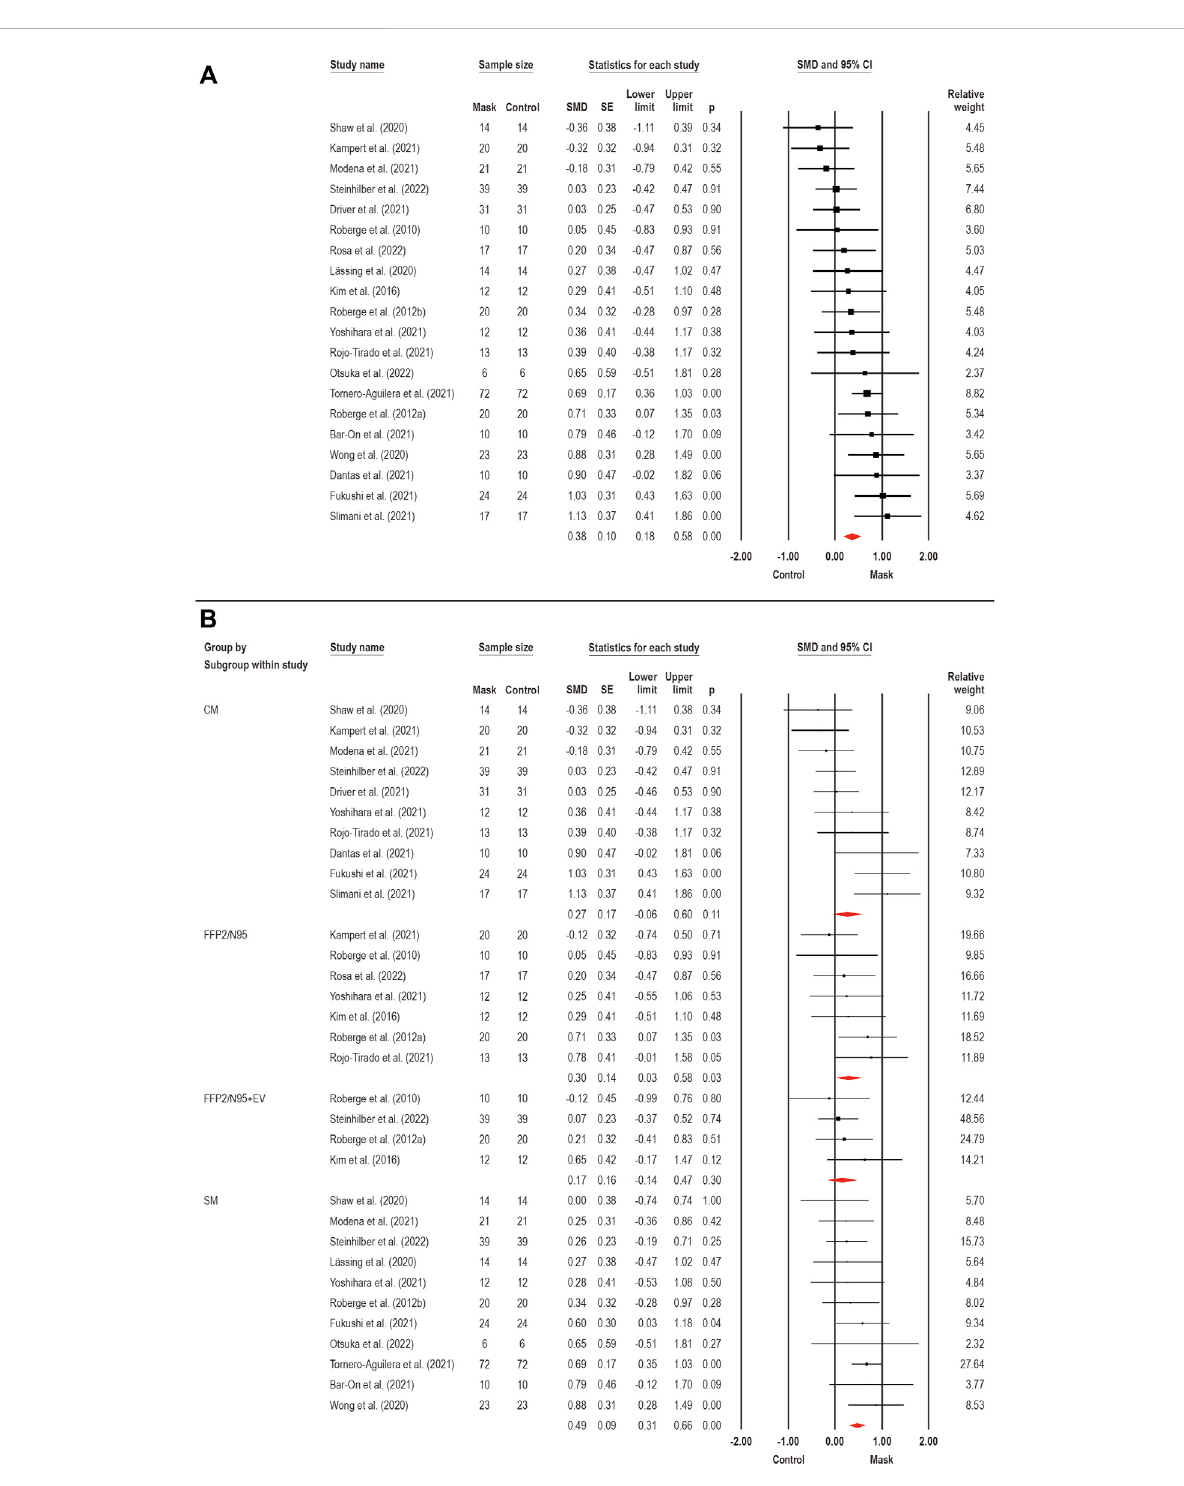
FIGURE 4 Acute effects of face mask vs. control (unmasked condition) on perceived exertion. Forest plots with pooled standardized mean difference (SMD), standard errors (SE), and 95% con fi dence intervals (CI) are displayed: (A) analysis of face mask wearing effects on perceived exertion (SMD: 0.38; 95% CI 0.18 – 0.58; p < 0.001; I 2 = 46%); (B) subgroup analysis of face mask wearing effects by face mask type [CM: clothing mask (SMD: 0.27; 95% CI − 0.06 to 0.60; p = 0.11; I 2 = 62%); SM: surgical mask (SMD: 0.49; 95% CI 0.31 – 0.66; p < 0.001; I 2 = 0%); FFP2/N95: facepiece respirator type 2 (SMD: 0.30; 95% CI 0.03 – 0.58; p = 0.03; I 2 = 0%); and FFP2/N95 + EV: facepiece respirator type 2 with exhalation valve (SMD: 0.17; 95% CI − 0.14 to 0.47; p = 0.30; I 2 =